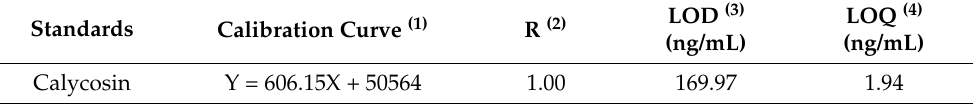
Table 3. Calibration curves for determining the LOD and LOQ values of standards ( n = 3).